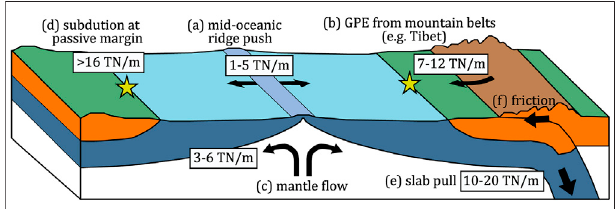
FIGURE 1 | Simpli fi ed sketch illustrating magnitudes of integrated differential stress observed on earth arising from: (A) ridge push (Mahatsente, 2017), (B) gravitational potential energy (GPE, Schmalholz et al., 2019) and (C) shear tractions generated by mantle fl ow (Kendall and Lithgow-Bertelloni, 2016). (D) In comparison, minimum differential stress required for subduction initiation at a passive margin is 16 – 20 TN/m (Zhong and Li, 2020) (E) slab pull (Turcotte and Schubert, 2014) (F) frictional resistance at plate interface. The orange and dark blue layers represent the crust and the mantle lithosphere,